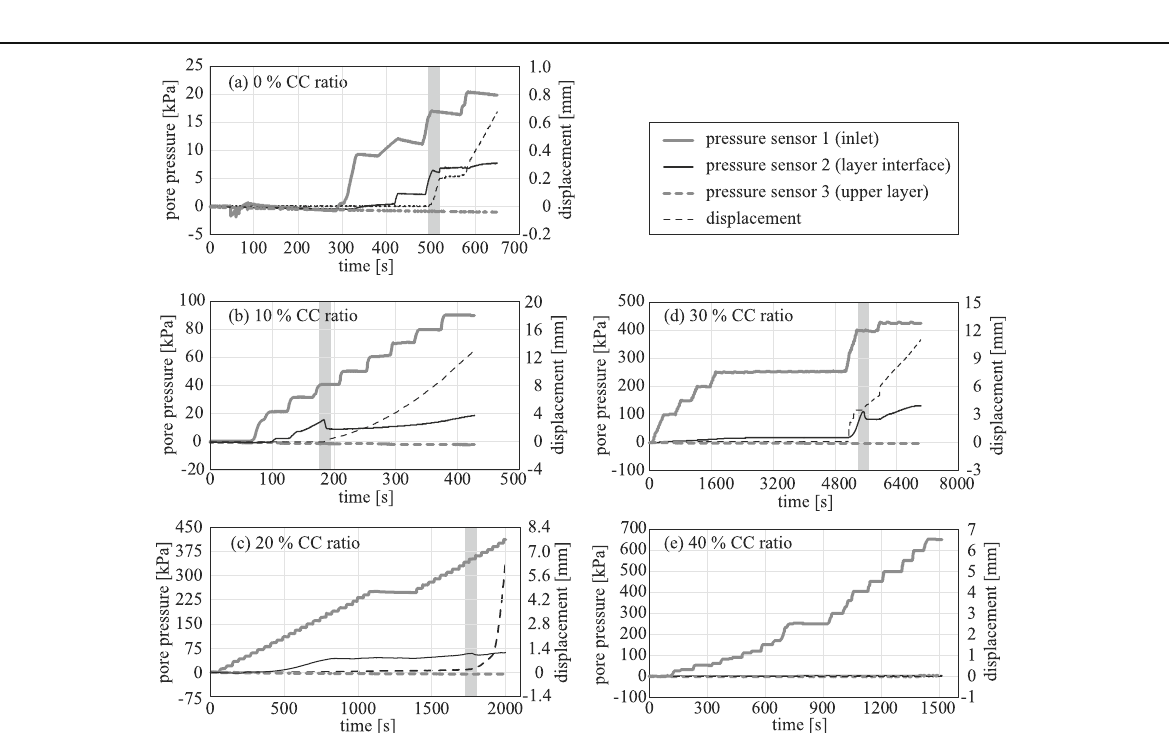
Fig. 7 Photograph of the two-layer specimen: a before and b after the